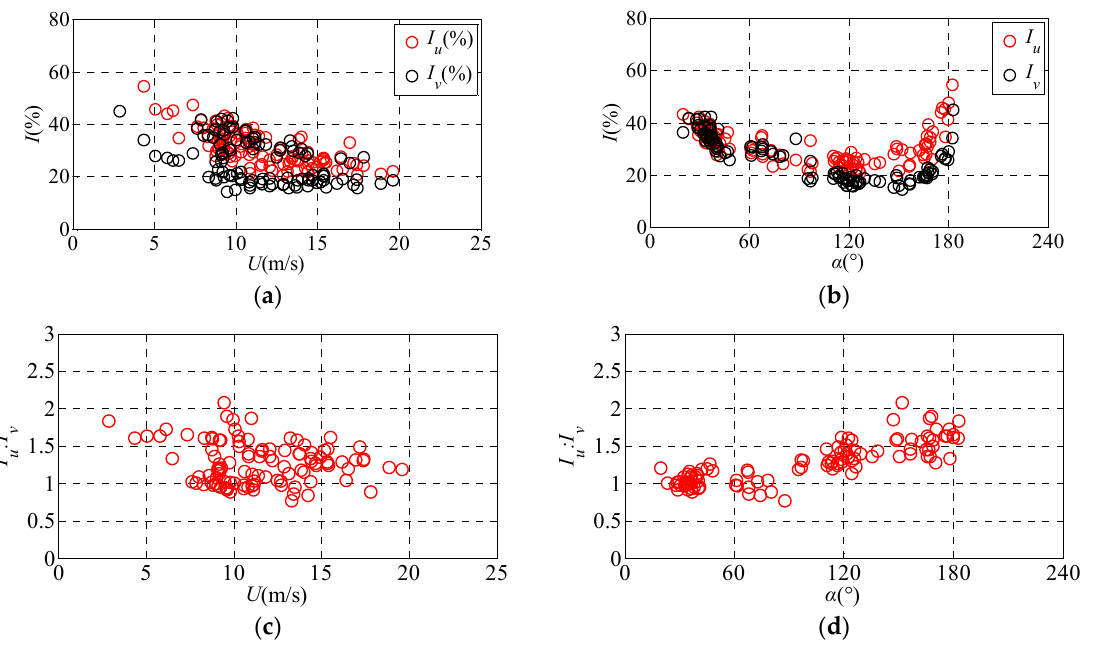
Figure 7. The measured longitudinal and lateral turbulence intensities. ( a ) I u and I v with respect to 10-min U ; ( b ) I u and I v with respect to wind direction; ( c ) I u : I v with respect to 10-min U ; ( d ) I u : I v with respect to wind direction.